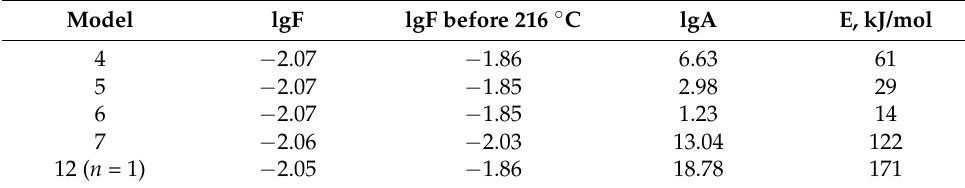
Table 3. Results of the modeling of the ethylenediamine with m / z =